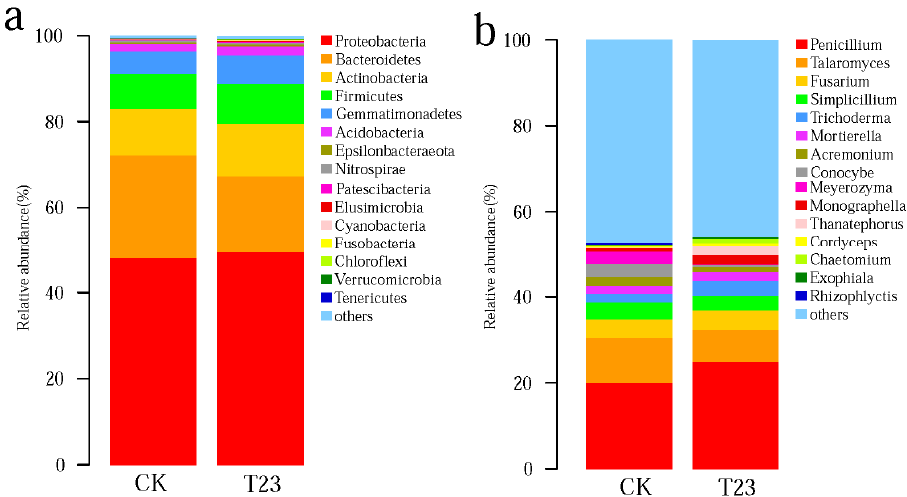
Figure 3. Composition of soil microbial communities in the muskmelon rhizosphere (top 15 in relative abundance). ( a ) Communities’ structure at the level of bacterial phylum. ( b ) Communities’ structure at the fungal genera level.